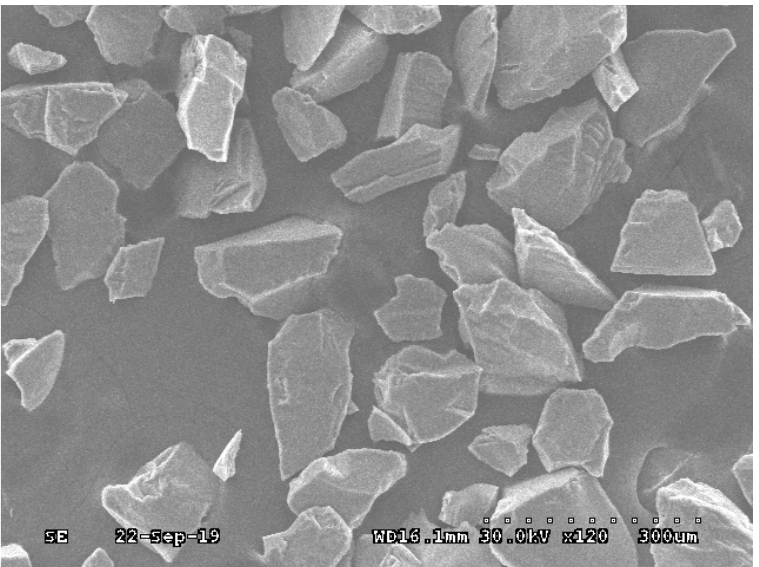
Figure 1. SEM image of a quartz sample.